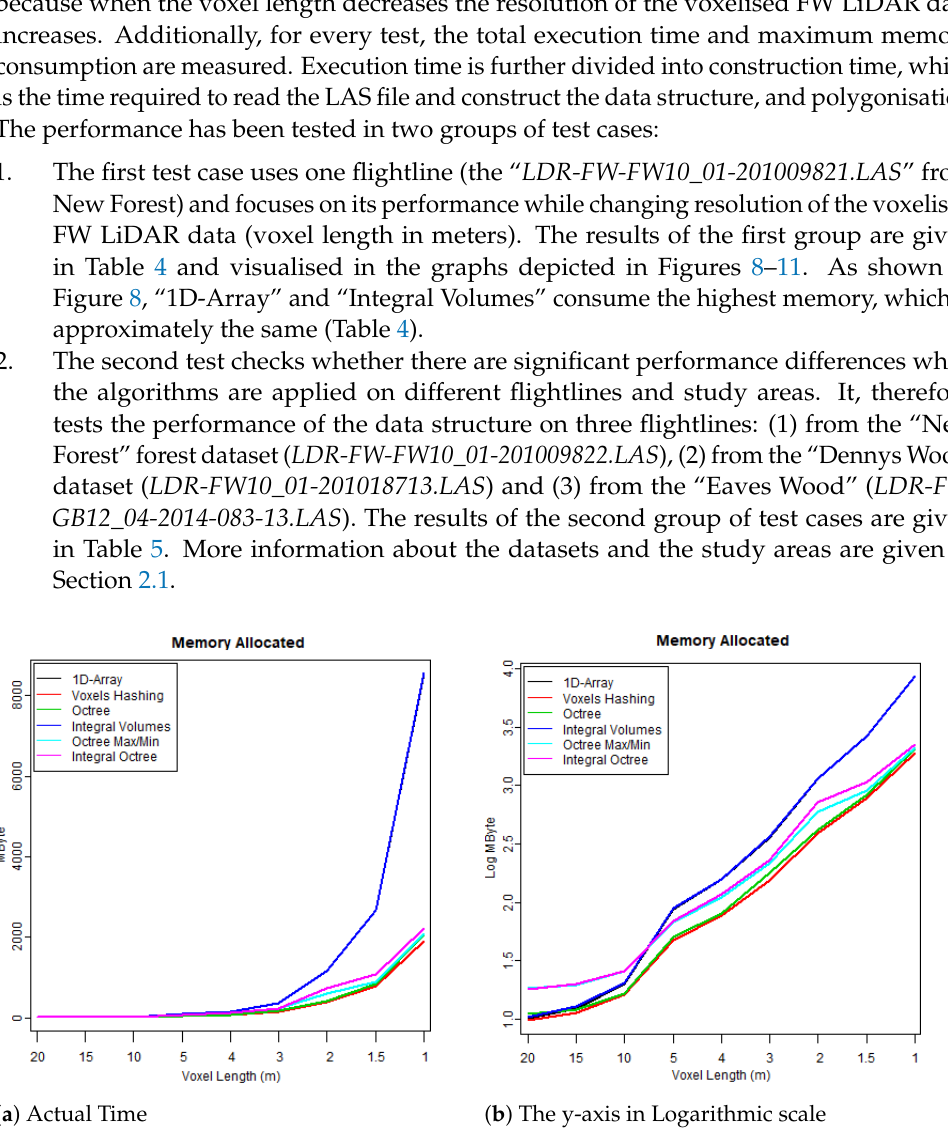
Figure 8. Maximum memory consumption at run